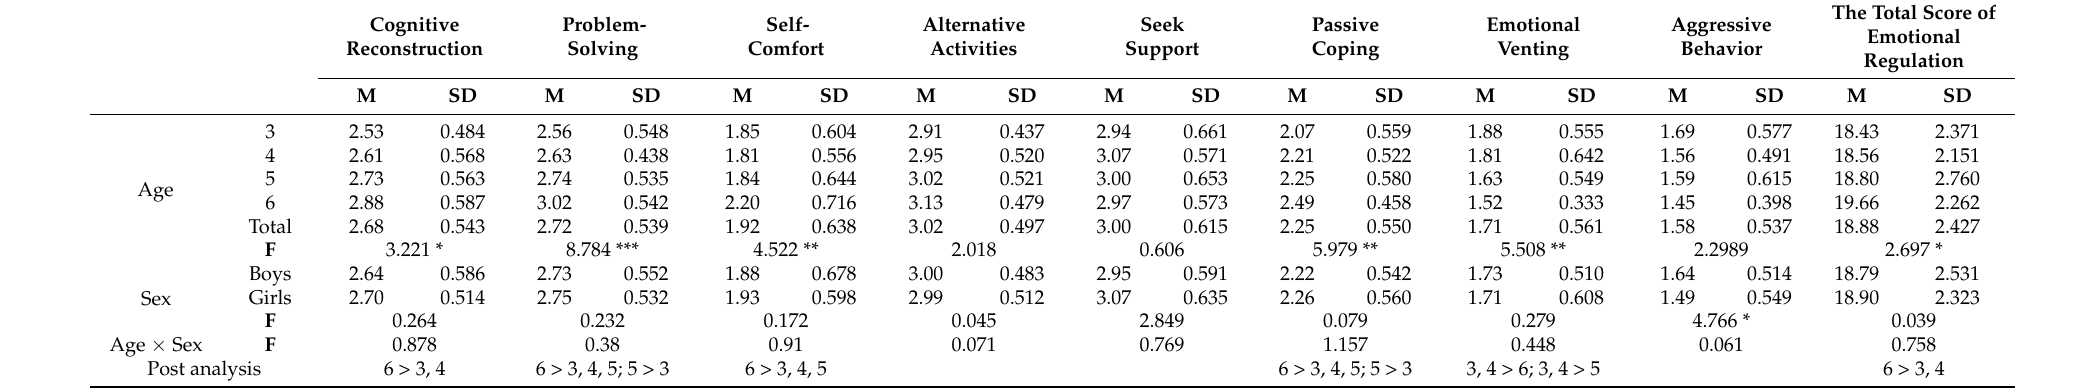
Table 4. General information and difference analysis of emotional